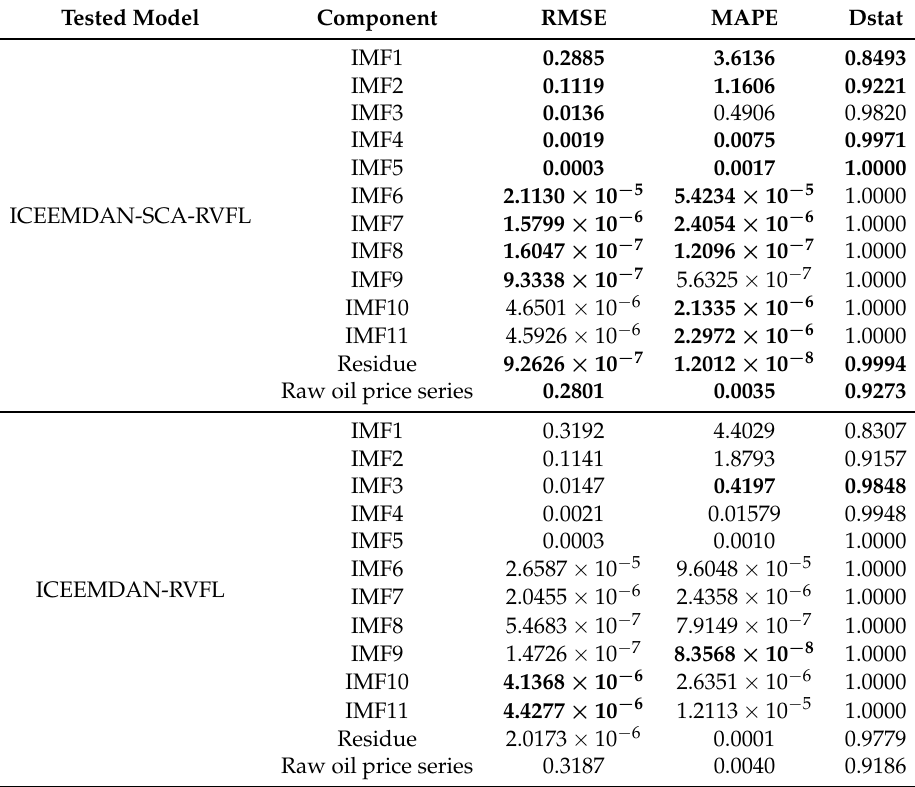
Table 8. Prediction results of each decomposed